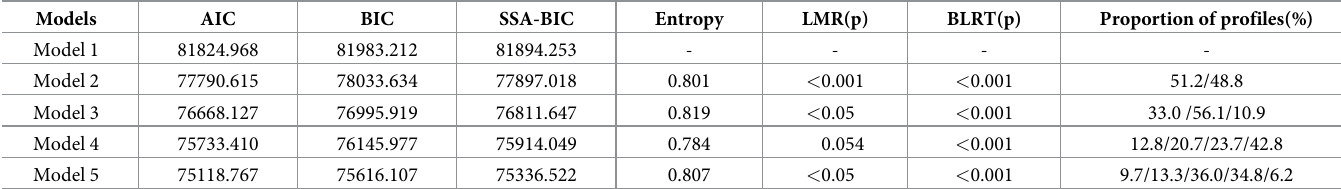
Table 1. Summary table of fitness indexes to adjusted alternative models of psychological adaptation to online